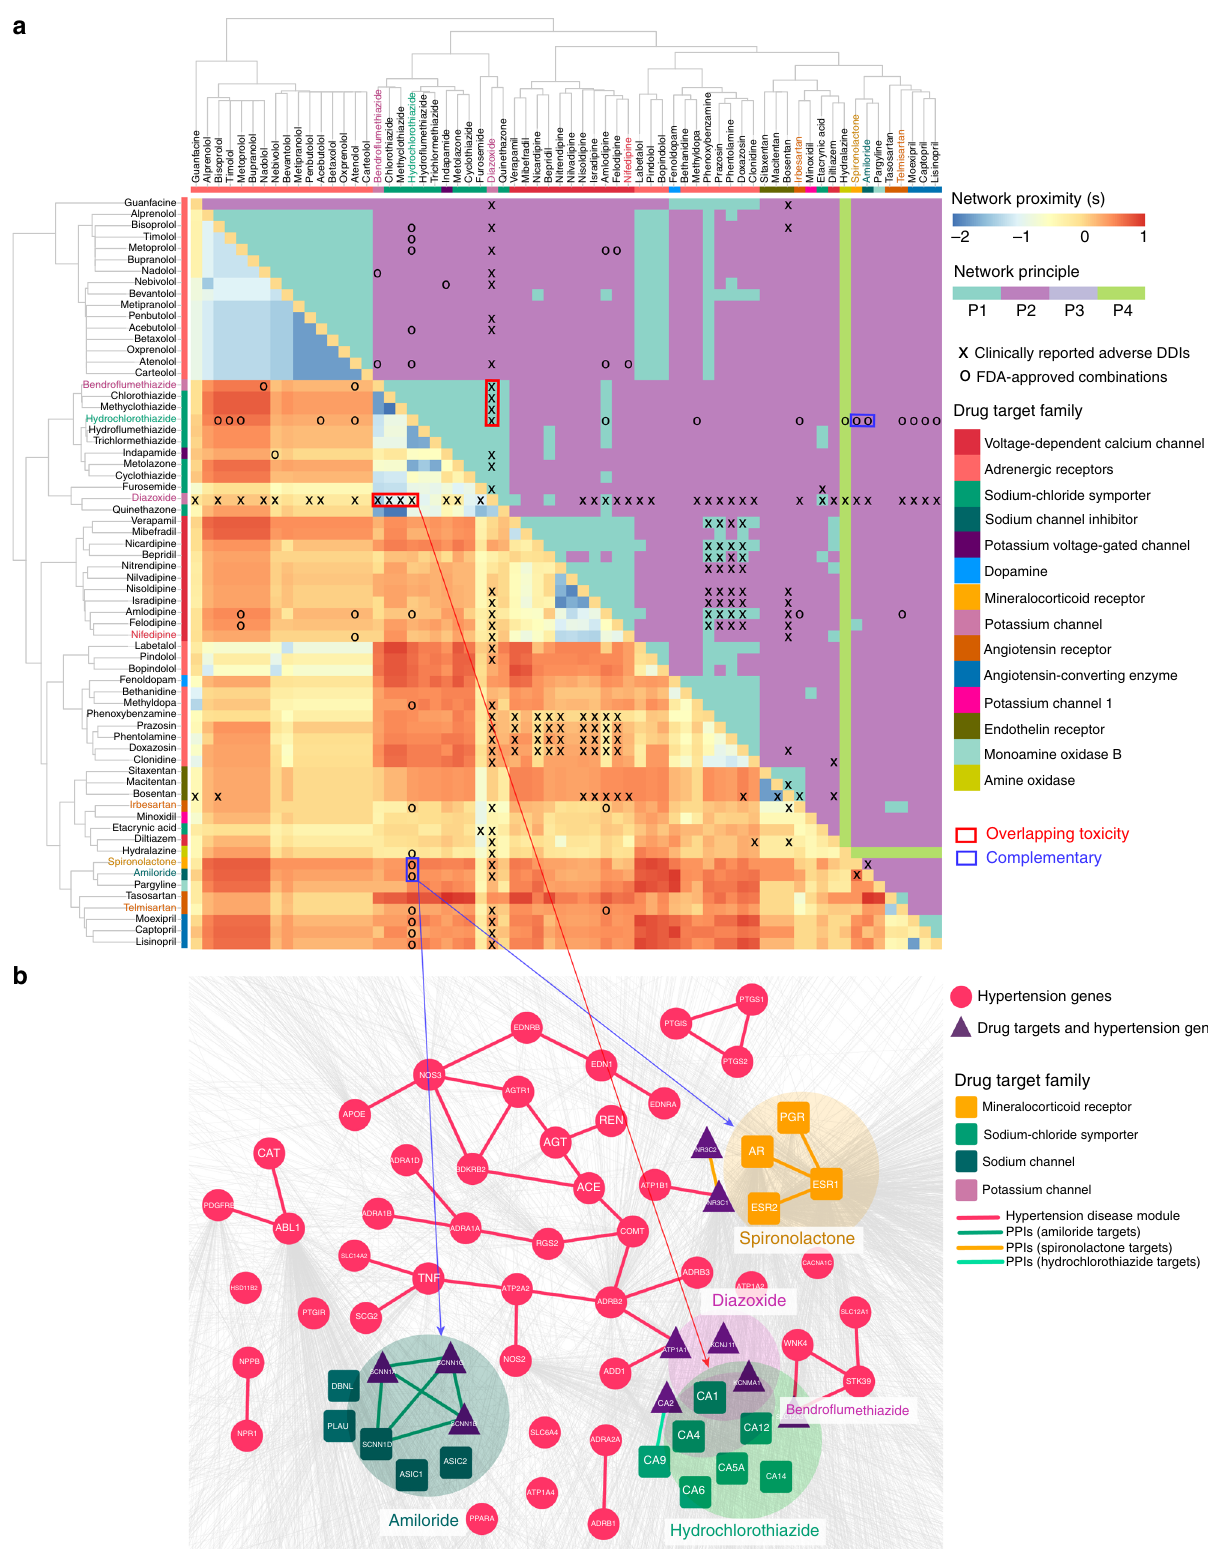
Here we documented the predictive power of Complementary Exposure in two complex diseases (hypertension and cancer) based on known drug combination data from publicly available databases. Therefore, future work is needed to explore the gen- eralizability of our fi ndings to other diseases.